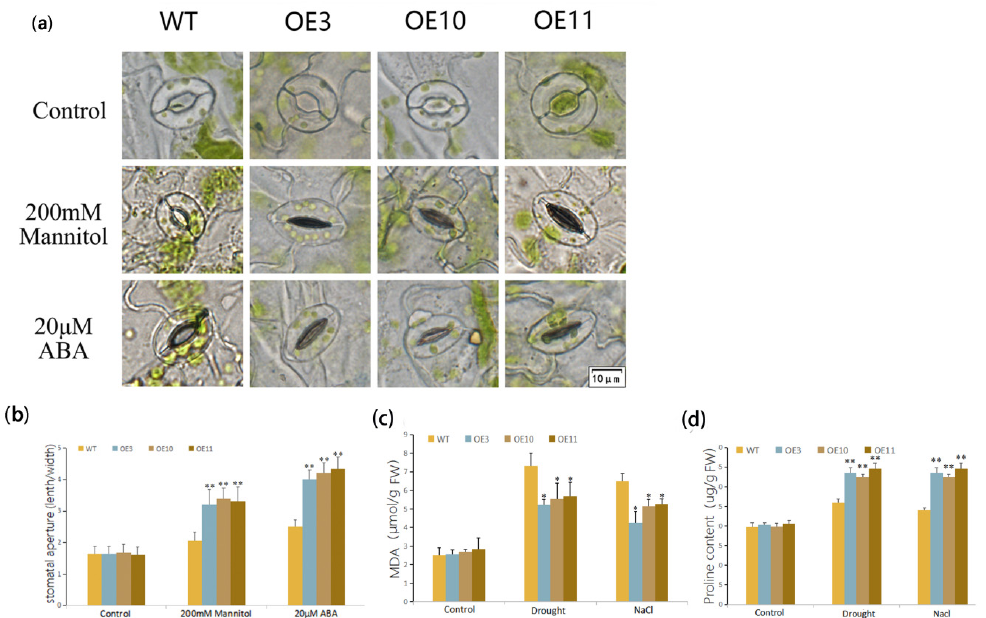
Figure 5. Evaluation of physiological indices responsive to stress. ( a , b ) Stomatal aperture of MfWRKY70 transgenic and WT in response to 200 mM mannitol and 20 µM ABA treatments. ( c , d ) Malondialdehyde (MDA) content ( c ) and proline (Pro) content ( d ) were measured in OE lines and wild type (WT) plants upon drought and salinity stress at four weeks old. Data are presented as mean and SD values of three independent experiments. Asterisks indicate significant difference (* p < 0.05, ** p < 0.01, by Student’s t -test) comparing to WT.